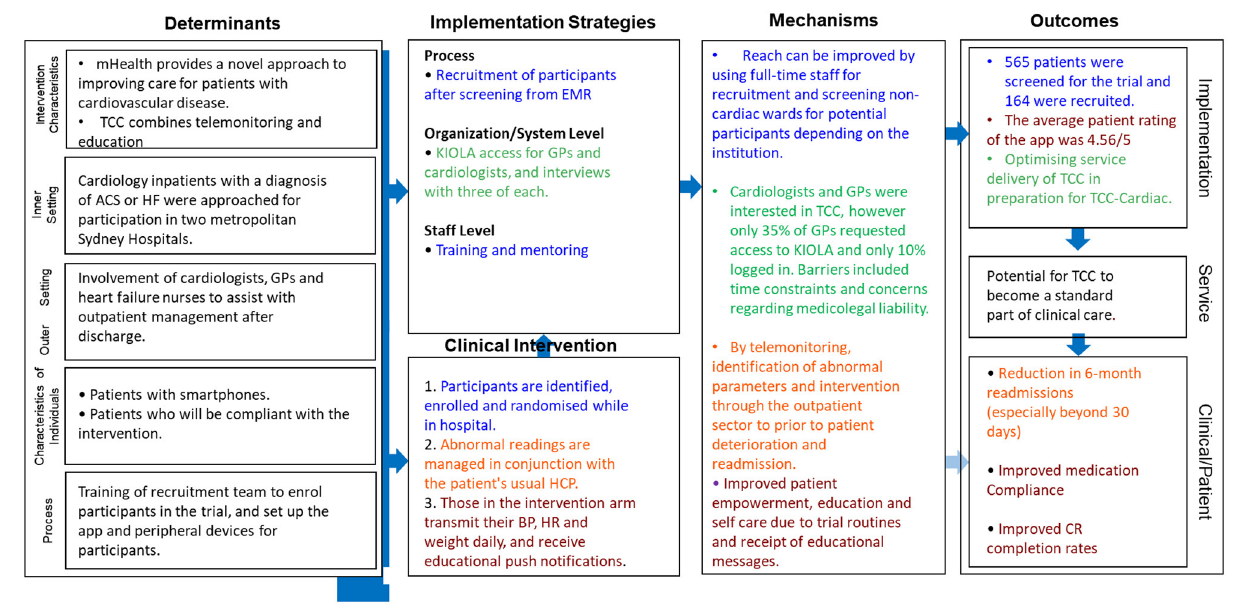
FIGURE 1 | Implementation research logic model (IRLM) for the TCC process evaluation, which describes the contextual determinants, implementation and mechanisms, and outcomes as per the standard process evaluation procedure. The four themes as identified within the refined IRLM relate to the actors involved: the hospital staff providing and delivering the intervention (blue colour within IRLM), the staff monitoring and responding to the patient recordings, healthcare practitioners who care for patients after discharge (GPs, cardiologists and HFOS) and patients participating in the TCC program (brown)”. ACS, acute coronary syndrome; BP, blood pressure; EMR, electronic medical record; GP, general practitioner; HCP, healthcare provider; HF, heart failure; HFOS, heart failure outreach service; HR, heart rate; TCC, TeleClinical